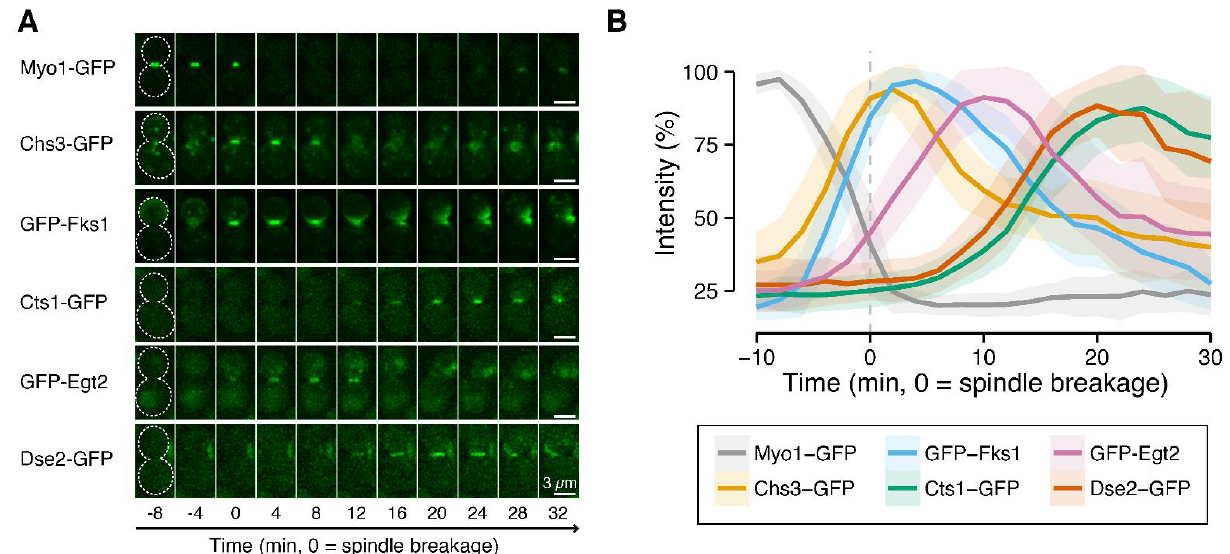
Figure 4. Kinetics of Dse2 and Egt2 (cluster V) proteins and proteins involved in cytokinesis and cell separation. ( A ). Images of green fluorescent protein (GFP)-tagged cluster V proteins and proteins involved in cytokinesis and cell separation. Montages of cells were created from frames selected from time-lapse series consisting of images taken at 2-min intervals. The white dotted line represents the cell outline. The following strains were used: YEF10861 ( MYO1-GFP mScarlet- TUB1 ), YEF10856 ( CHS3-GFP mScarlet-TUB1 ), YEF10857 ( GFP-FKS1 mScarlet-TUB1 ), YEF10862 ( CTS1-GFP mScarlet-TUB1 ), YEF10879 ( GFP-EGT2 mScarlet-TUB1 ), and YEF10858 ( DSE2-GFP mScarlet-TUB1 ). ( B ). Kinetics of the GFP-tagged proteins indicated in “ A ”. The vertical dashed line shows timing of spindle breakage. Bold lines and associated shaded bands represent mean and SD values, respectively. n > 23 for each strain.